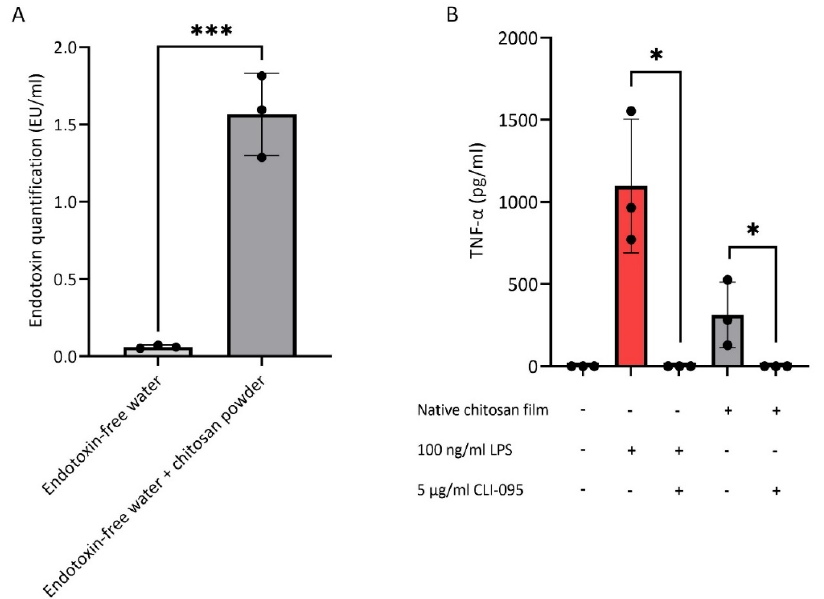
Figure 2. ( A ) Endotoxin quantification of native chitosan powder suspended in endotoxin free water determined by LAL assay. N = 3. ( B ) TNF- α production of PBMCs cultured on native chitosan films or with 100 ng/mL LPS, with or without the TLR4 small molecule inhibitor, CLI-095, for 18 h. PBMCs cultured on untreated plate served as negative control. (+) indicates included and (-) not included compounds. N = 3 (black circles indicate repeats); * p < 0.05; *** p < 0.001 (black comparator lines).